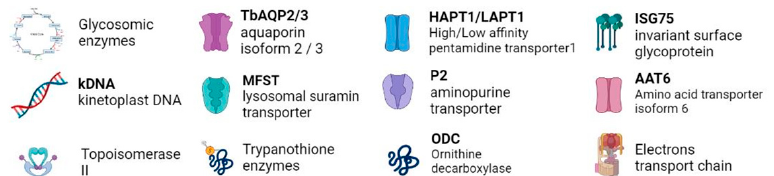
Figure 2. Drugs used to treat HAT and their mechanisms of action are illustrated. The different targets and transporters have been reported [41–47]. Created with Biorender.com, agreement number PT23Y61FRT 22 May 2022.